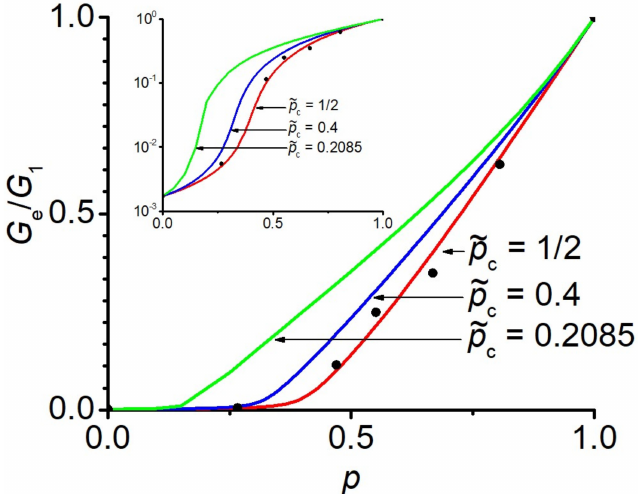
Figure 7. Normalized shear moduli of block copolymers of styrene and butadiene (filled circles). Experimental values are taken from [55]: G 1 / G 2 = 581.82, ν 1 = 0.335, ν 2 = 0.499. The inset shows the same data on the logarithmic